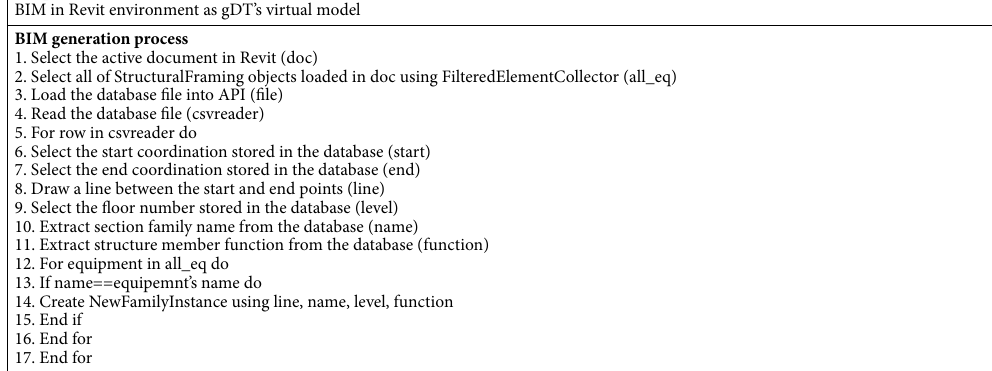
Table 5. Pseudocode for automatically creating BIM using information obtained from point